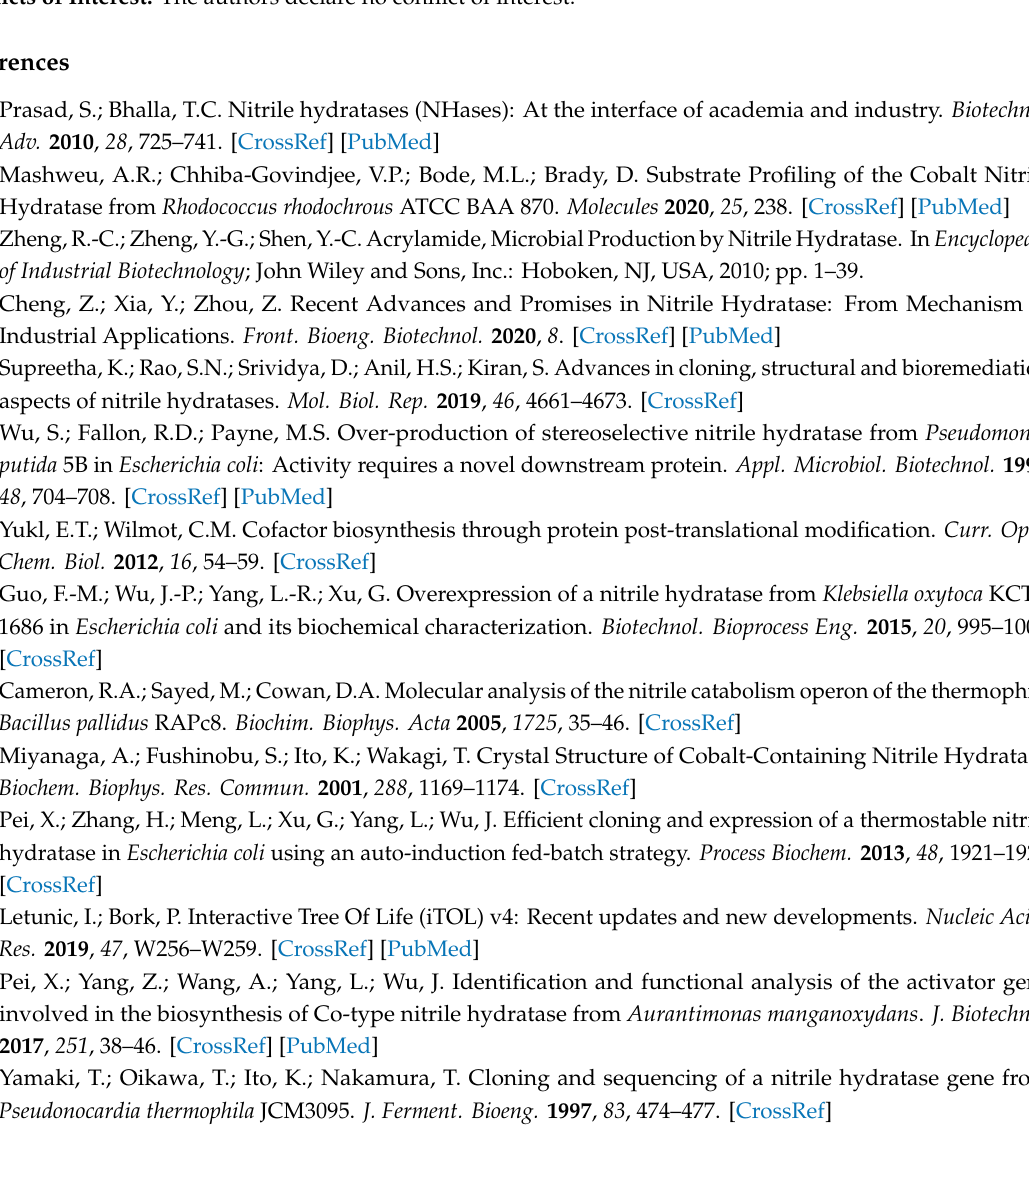
Figure S1–S5: SDS-PAGE of